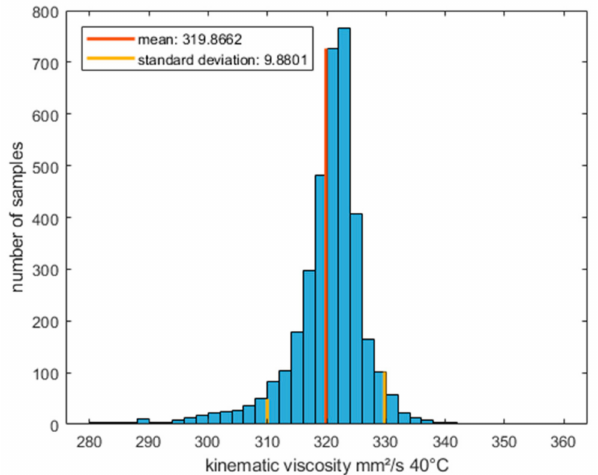
Figure 10. Distribution of the kinematic viscosity at 40 ◦ C of PAO